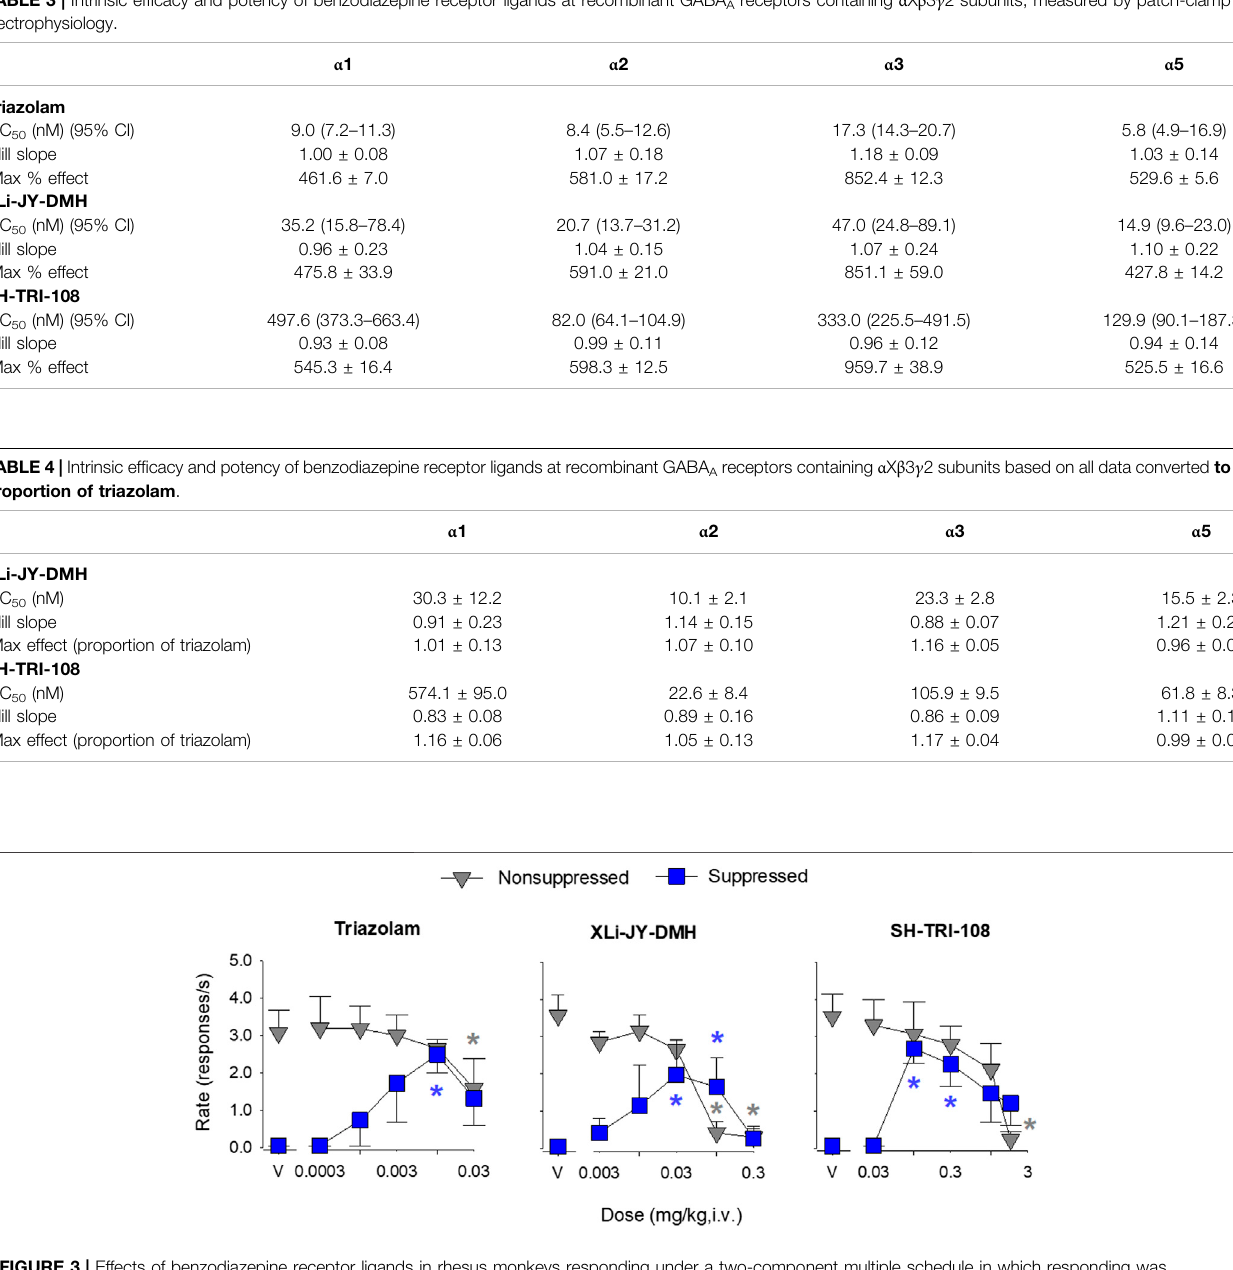
FIGURE 3 | Effects of benzodiazepine receptor ligands in rhesus monkeys responding under a two-component multiple schedule in which responding was maintained under a fi xed-ratio schedule of food delivery in the absence (non-suppressed responding) and presence of response-contingent electric shock (suppressed responding).Dataaremean ± SEMforN (cid:1) 3rhesusmonkeys.Blueasterisks(*): p < 0.05vs.vehicleforsuppressedresponding(bluesquares);Grayasterisks(*) p < 0.05 vs. vehicle for non-suppressed responding (gray triangles), Fisher ’ s method.